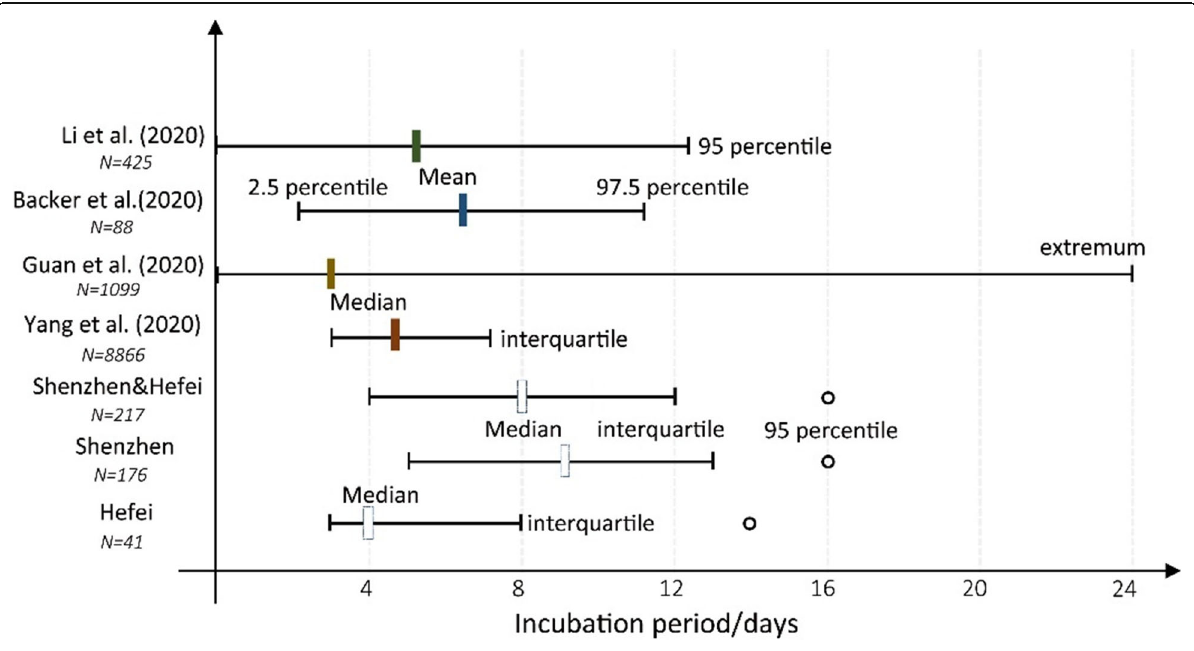
Fig. 7 Incubation periods of COVID-19 from different